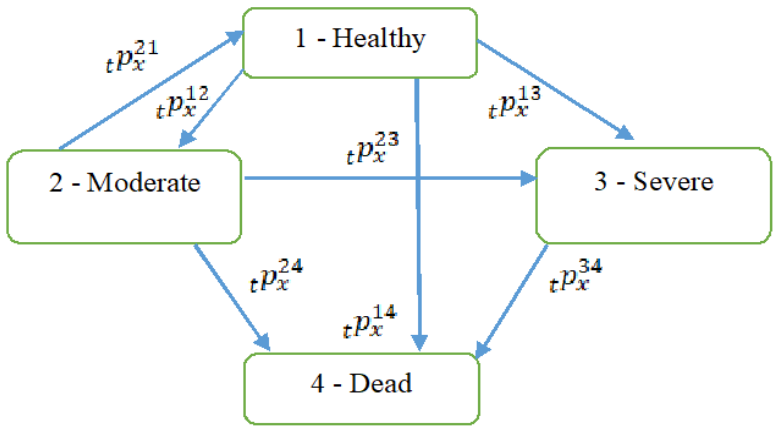
Figure 1. Multiple Health States Markov Model for Consumer’s Life Cycle.